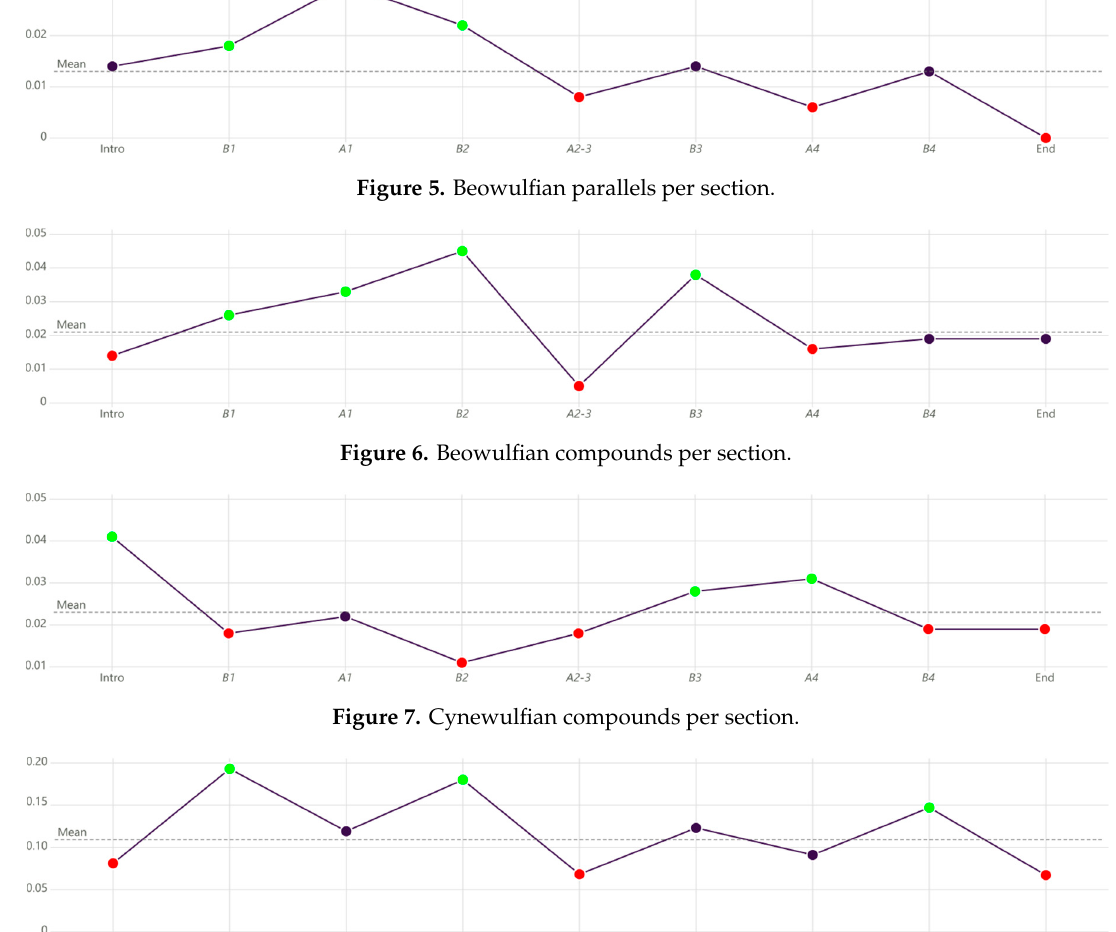
Figure 8. Andrean compounds per section.